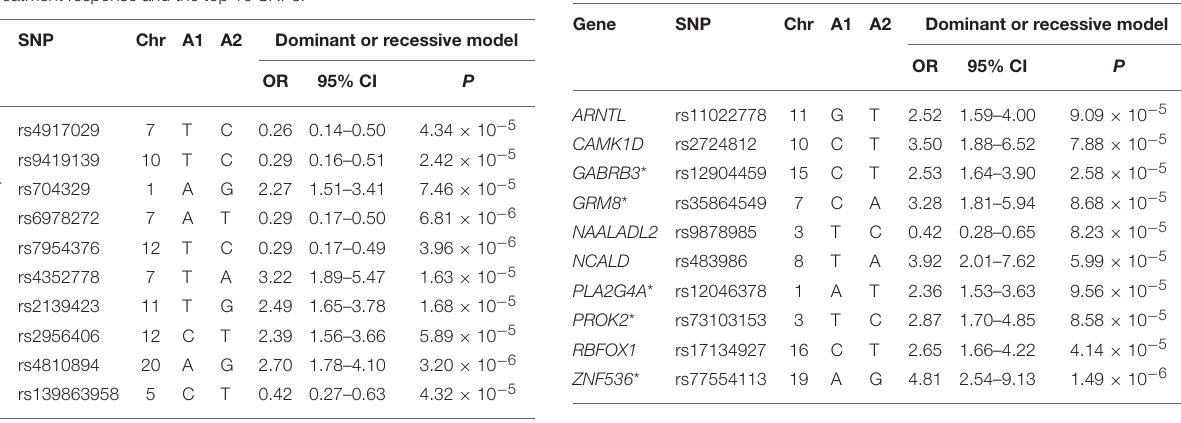
TABLE 3 | Odds ratio analysis with odds ratios after adjustment for covariates between remission and the top 10